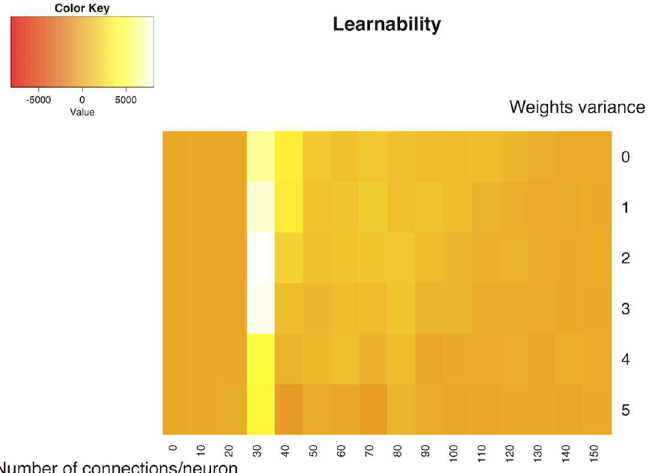
Fig 7. Performance of learning depending of network connectivity and initial weights variance. Learnability is definedas the averagedifference betweenthe firing rate of the Output Zone during the first 100 seconds and the last 100 seconds. The ideal regionof the parameter space to obtain good learningresults is between20 and 30 connections per neuron. By comparison, the variance has less influence. Statistical results for N = 20 networks for each parameter